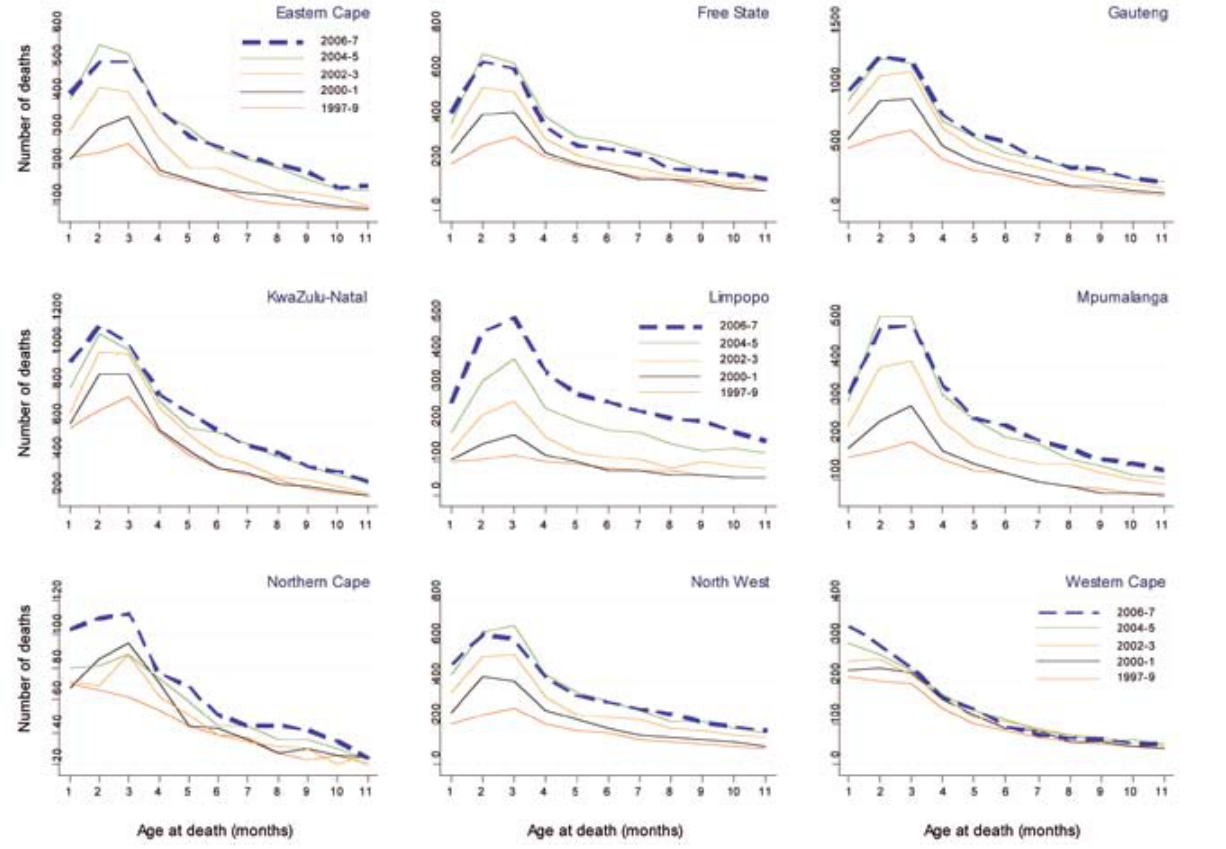
Fig. 1. Registered post-neonatal deaths in South African infants by age in months, province and year of death registration (note that the scale differs between